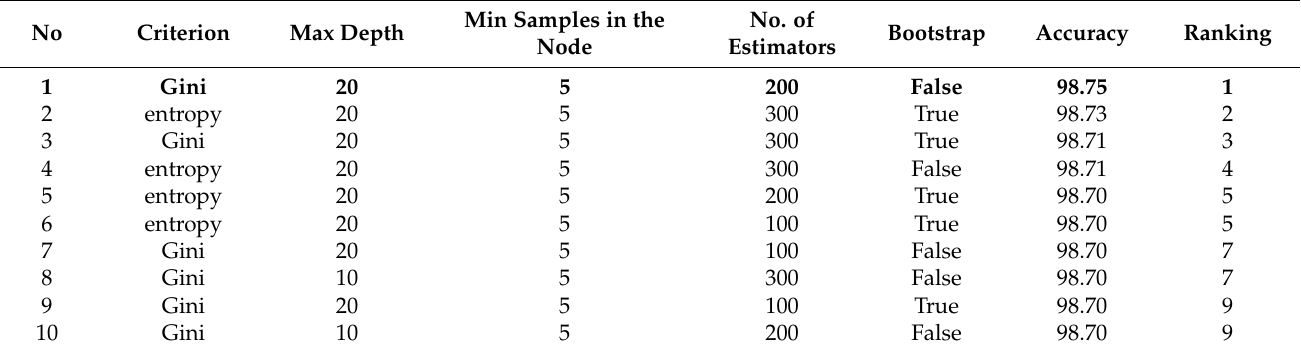
Table 7. Random forest algorithm hyperparameter optimization